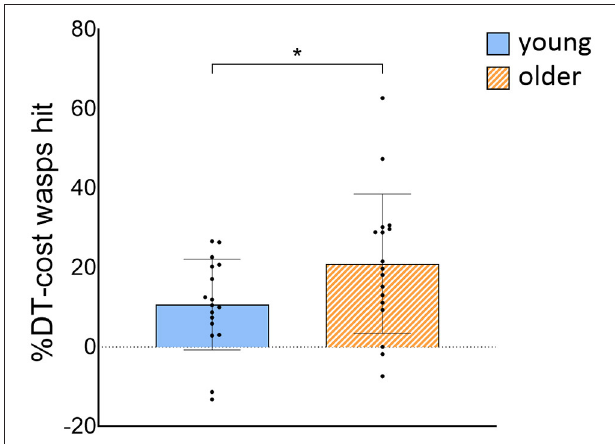
FIGURE 4 | %DT-cost of the number of wasps hit for young and older adults. %DT-cost was calculated as the difference between DT and ST wg performance as a percentage of ST wg performance, and is displayed as mean ± SD. Individual data points represent %DT-cost for each participant. *Significant group difference ( p < 0.05). ST wg , single-task wasp game; DT,